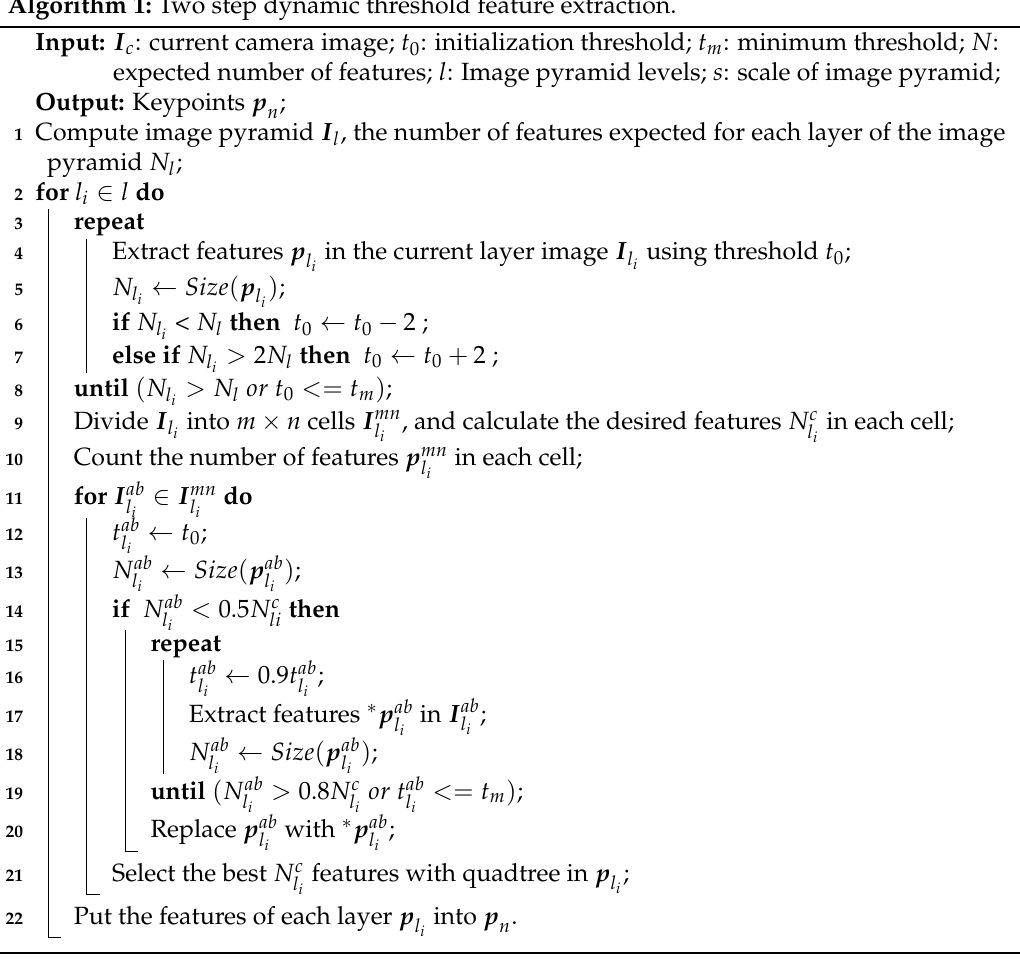
Algorithm 1: Two step dynamic threshold feature